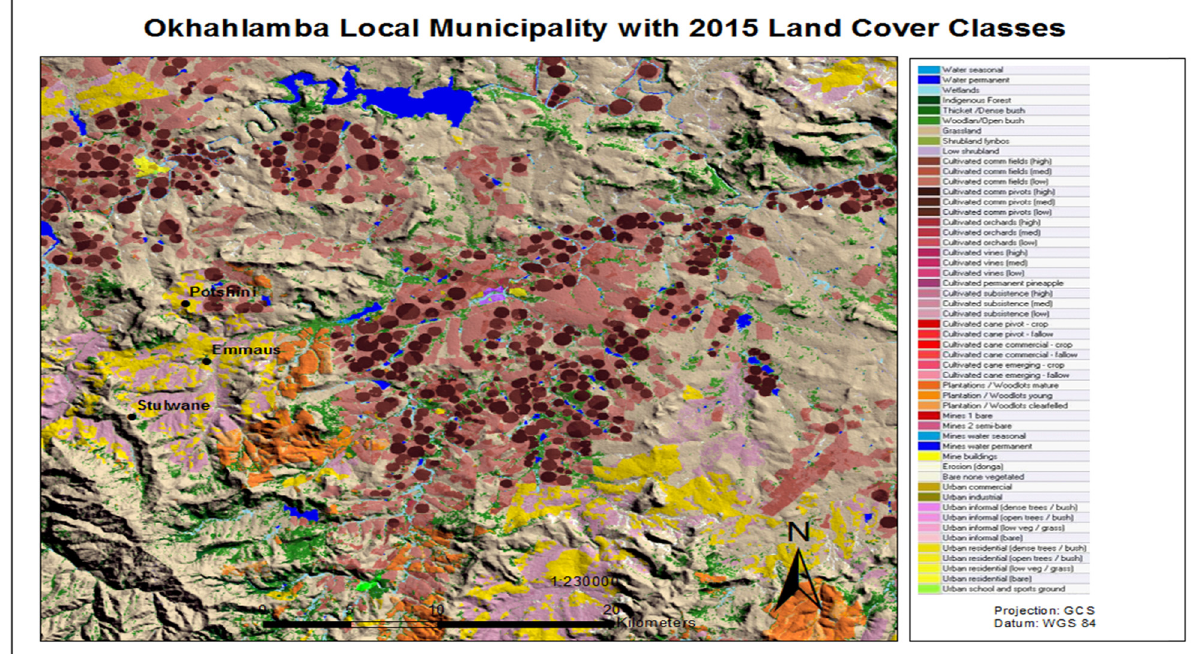
Figure 1: Map of the study